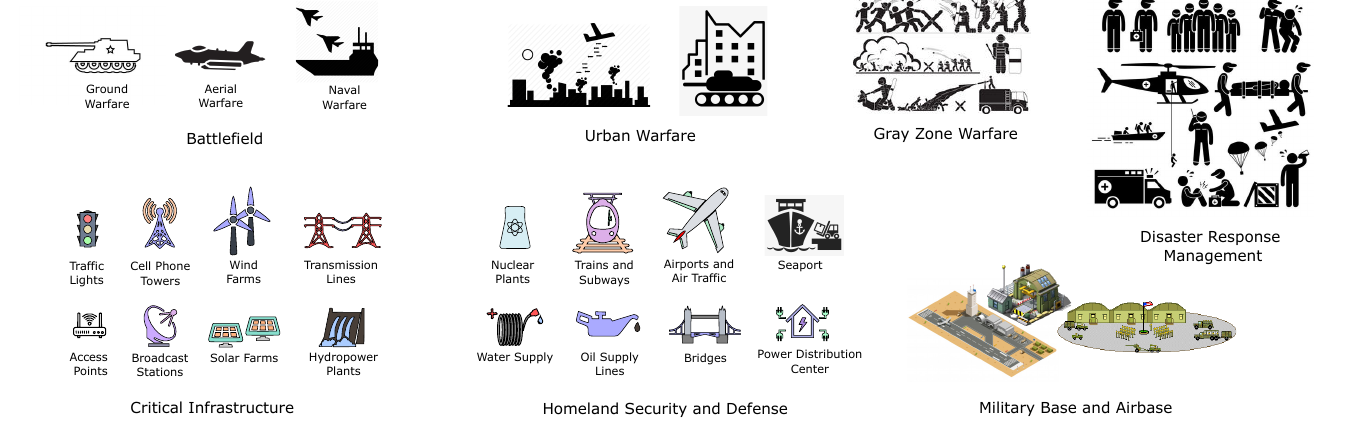
Figure 5. Domains of situational